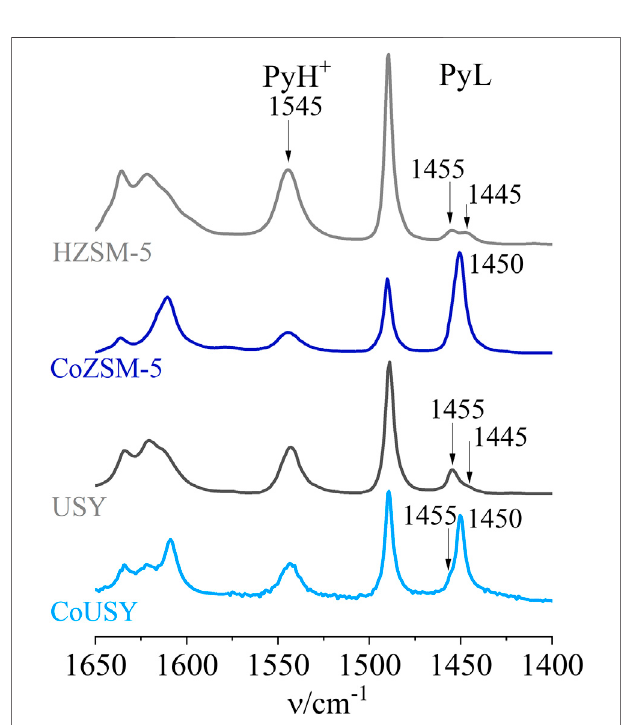
FIGURE5| IRspectraofpyridine sorptionfortheCoUSYandCoZSM-5 catalysts juxtaposed with the spectra of reference zeolite supports.